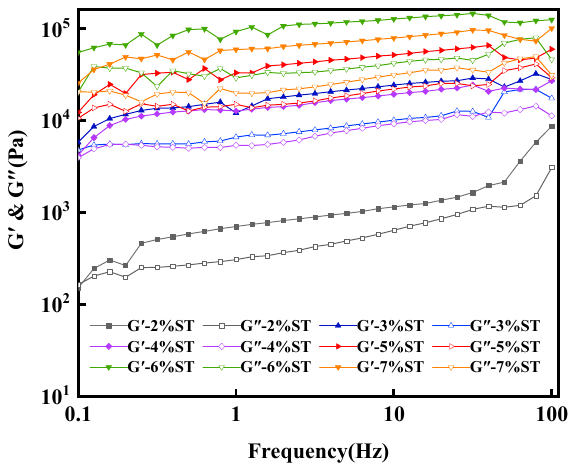
Figure 4. Viscoelastic properties of stigmasterol organogels from the different stigmasterol concentrations (2–7%) with the scanned frequency range from 0.1 Hz to 100 Hz at 25 °C. Those results in rheology follow the same tendency observed in the oil binding capacity, that is, as the concentration of stigmasterol increased, G’ values and the oil binding capacity increased. However, the G’ value decreased at the stigmasterol concentration of 7%, which could mean that when the stigmasterol concentration reached 7%, the organogel system was under a supersaturated state. This supersaturation may affect the change of crystal structural units in the organogel [35], leading to the decrease in its structural integrity, decreasing the G’ value. It was reported that the supersaturated state could increase the nucleation rate of crystals in the organogels [36], resulting in the formation of more individual networks in the organogels system; however, those crystal structures from different single networks were usually less entangled than the permanent junction of crystal structure in an organogels network. Therefore, the integrity of the structure and the overall mechanical properties decreased with the increasing nucleation rate and the number of structural elements. The results of frequency scanning showed the formation of a gel network and the physical interaction between organgeltor and vegetable oil. A temperature ramp test of organogels is illustrated in Figure 5 to study the temperature- dependent flow behavior of the stigmasterol organogels. As the scanning temperature increased, the G’ and G” values of organogels were significantly reduced and the critical phase transition temperature (G’ = G”) gradually emerged at the stigmasterol concentration of 2–6%. This result indicates that the organogels showed a viscous behavior at